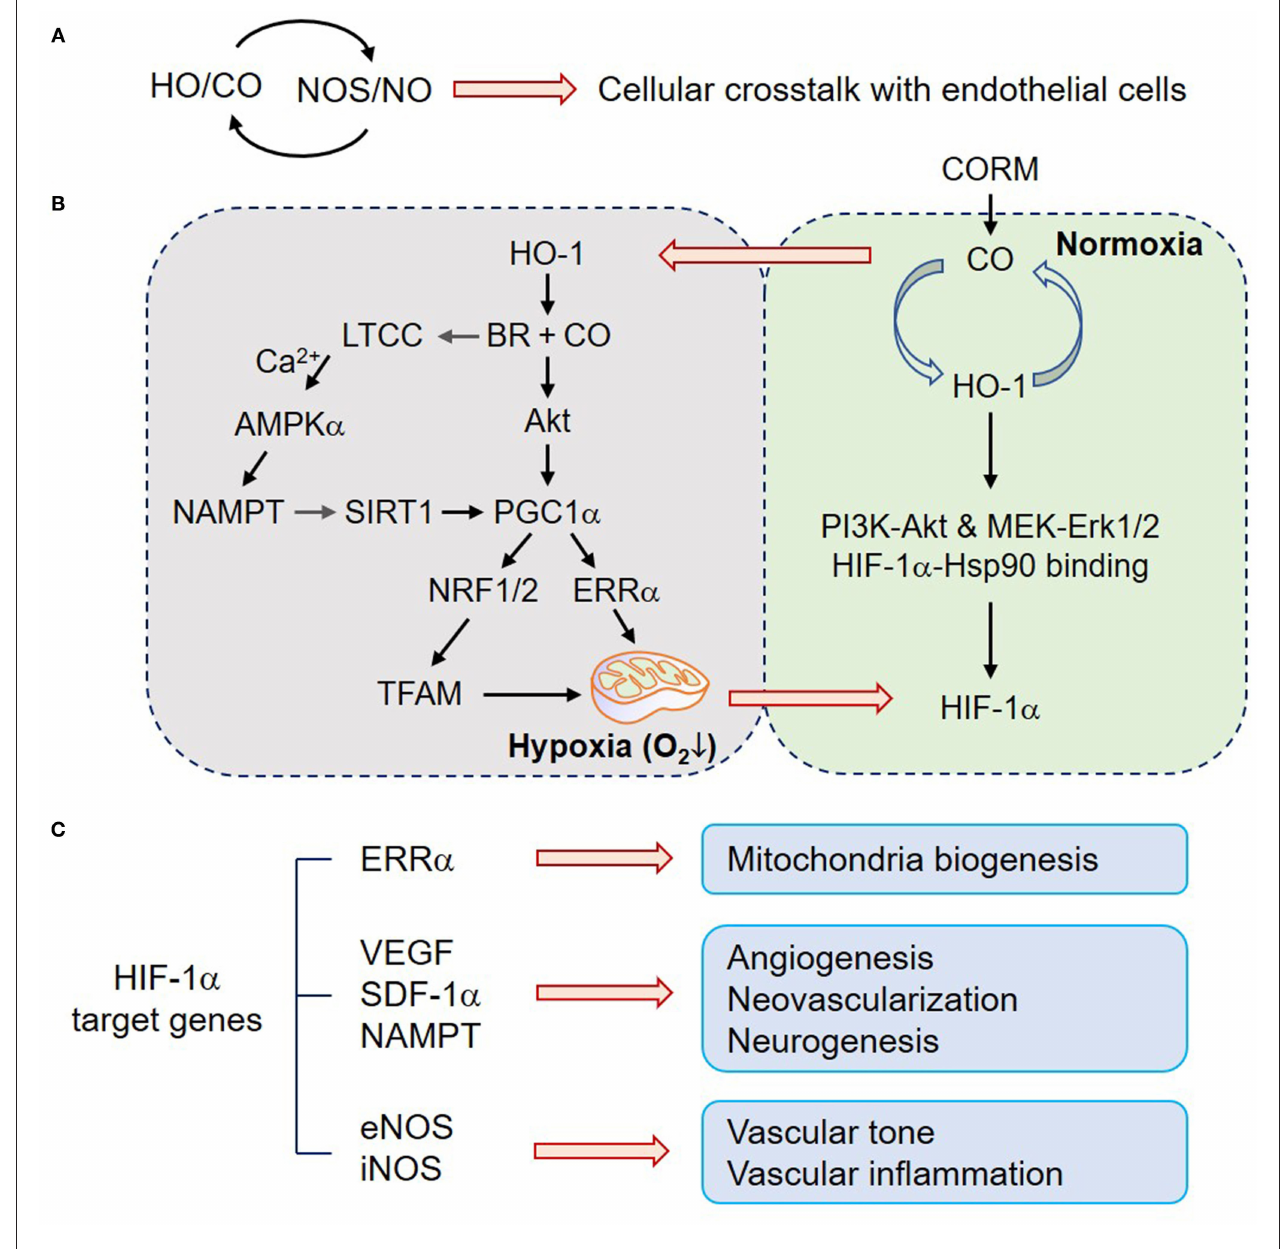
FIGURE 1 | CO upregulates mitochondria biogenesis, angiogenesis, and neurogenesis. (A) HO/CO–NOS/NO crosstalk may play beneficial roles in ECs through cellular communications. (B) In normoxic astrocytes, the HO-1/CO pathway upregulates HIF-1 α protein level by translational facilitation through PI3K-Akt and MEK-Erk1/2 and protein stability through HIF-1 α -Hsp90 binding. In contrast, HO-1-mediated BR and CO production can induce LTCC activation, and consequent Ca 2 + influx triggers the AMPK α -NAMPT–SIRT1–PGC-1 α signaling cascade. CO also increases Akt-dependent PGC-1 α activation, NRF1/2 expression, and TFAM upregulation. PGC-1 α -ERR α -mediated mitochondrial biogenic activation transiently induces hypoxia (enhanced O 2 consumption) and HIF-1 α stabilization. (C) HO-1/CO pathway-mediated HIF-1 α stabilization transcriptionally expresses its putative target genes, such as ERR α , VEGF, SDF-1a, NAMPT, eNOS, and iNOS, which are related to mitochondria biogenesis, angiogenesis, neovascularization, neurogenesis, vascular tone, and inflammation. CO, carbon monoxide; HO-1, heme oxygenase-1; BR, bilirubin; PI3K, phosphoinositide 3-kinase; MEK, mitogen-activated protein kinase kinase; Erk, extracellular signal-regulated kinase; Hsp90, heat shock protein 90; HIF-1 α , hypoxia-inducible factor-1 α ; LTCC, L-type Ca 2 + channel; AMPK α , AMP-activated protein kinase α ; SIRT1, sirtuin 1; PGC-1 α , peroxisome proliferator-activated receptor-gamma coactivator-1 α ; NRF, nuclear factor erythroid-2-related factor; TFAM, mitochondrial transcription factor A; ERR α , estrogen-related receptor α ; VEGF, vascular endothelial growth factor; SDF-1 α , stromal derived factor-1 α ; NAMPT, nicotinamide phosphoribosyltransferase; iNOS, inducible nitric oxide synthase.